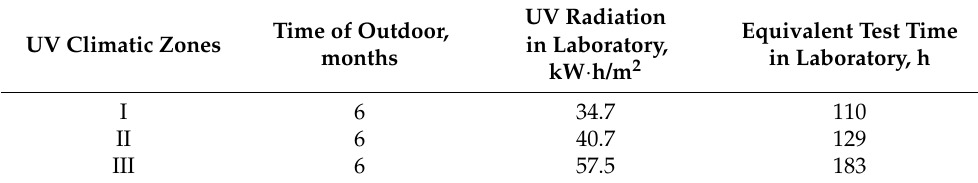
Table 4. Equivalent test time in the laboratory under the different UV radiation (Take 6 months as an example).